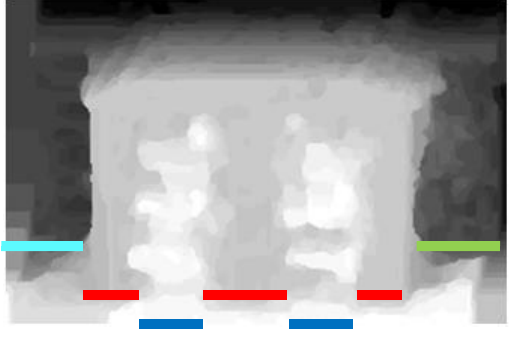
Figure 18. 3D point cloud of the facade shown in Figure 16. Data extracted from four overlapping vertical aerial photographs. Density of points is (10 × 17 cm) 43,180